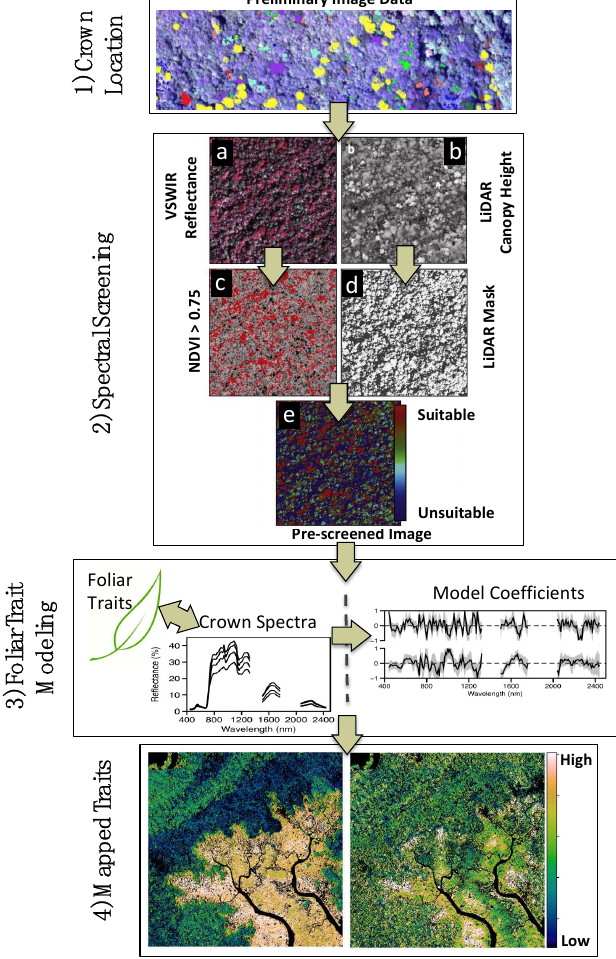
Figure 2. Diagram of foliar trait retrieval process. Steps include: (1) Identifying crowns in preliminary remote sensing imagery for foliar collection; (2) Prescreening of ( a ) Carnegie Airborne Observatory (CAO) Visible-to-Shortwave Infrared (VSWIR) imaging spectrometer data using ( b ) embedded Light Detection and Ranging (LiDAR) data on canopy height and gaps; ( c ) Minimum Normalized Difference Vegetation Index (NDVI) threshold of 0.75 ensures sufficient foliar cover in each analysis pixel; ( d ) Combining LiDAR-based canopy height and solar-viewing geometry, a mask is generated to remove pixels in shade, and ground and water surfaces; ( e ) A visual representation of the combination of the prescreening steps in terms of suitability for use in chemometric modeling; (3) Foliar trait modeling combining field-based biochemical data and remotely sensed spectra (in this model, normalized for brightness). This step can be executed in a variety of different way. We chose to evaluate trait retrieval in five subgroups of the calibration data before testing the model against the global holdout set (30%); (4) Foliar trait models are applied to airborne data across the landscape. Figure adapted from Asner et al. [15].